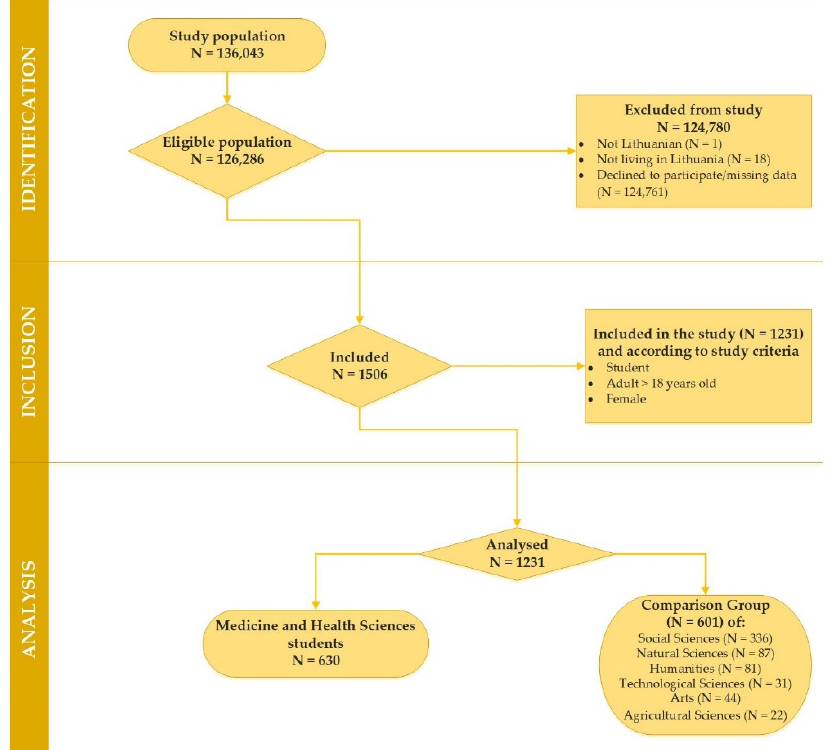
Figure 1. Consort flowchart depicting the reasons for the survey participants’ exclusion from the study.